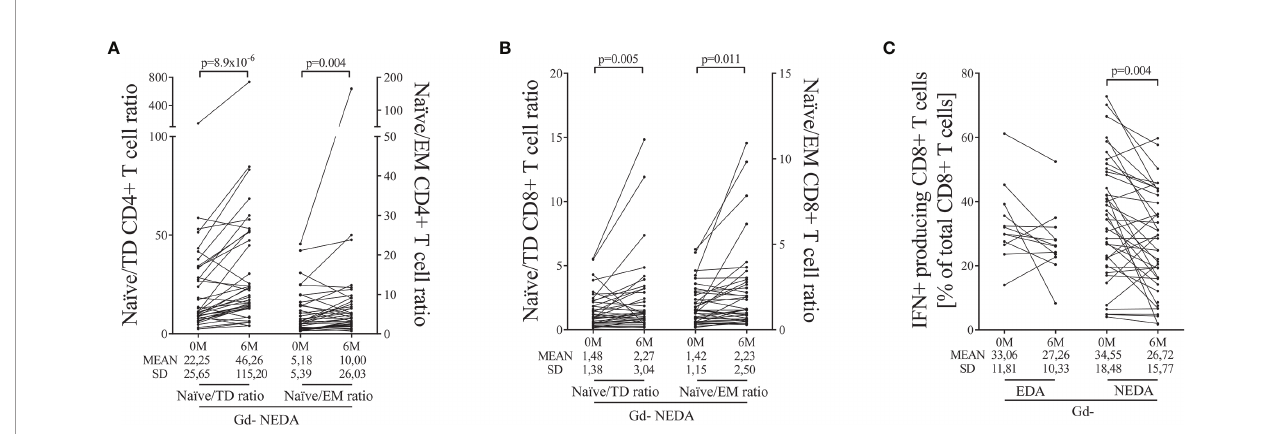
FIGURE 3 | Main changes in blood T cells after ocrelizumab treatment. T cells were obtained before (0M) and at 6 months (6M) of ocrelizumab treatment and classi fi ed based on their in fl ammatory status (presence [Gd+] or absence [Gd-] of gadolinium enhancing lesions at baseline) and response (NEDA or EDA) to treatment at one year of follow-up. N was 6, 10, 12 and 41 in Gd+ EDA, Gd+ NEDA, Gd- EDA and Gd- NEDA, respectively. Graphs showing changes in naïve/ effector ratios of CD4 (A) and CD8 (B) T cells, and changes in percentage of IFN g -producing CD8 T cells (C) relative to total CD8+ T cells. TD, terminally differentiated; EM, effector memory; IFN, gamma-interferon; SD, Standard deviation. Bonferroni-corrected p-values are shown.